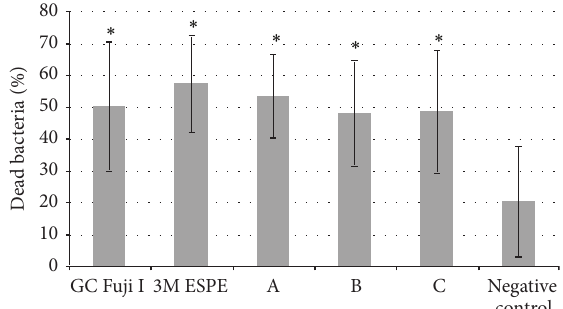
Figure 3: Dead adherent bacteria on the different ionomer glass cement materials in percent after live/dead staining. The materials were incubated with Streptococcus mutans for